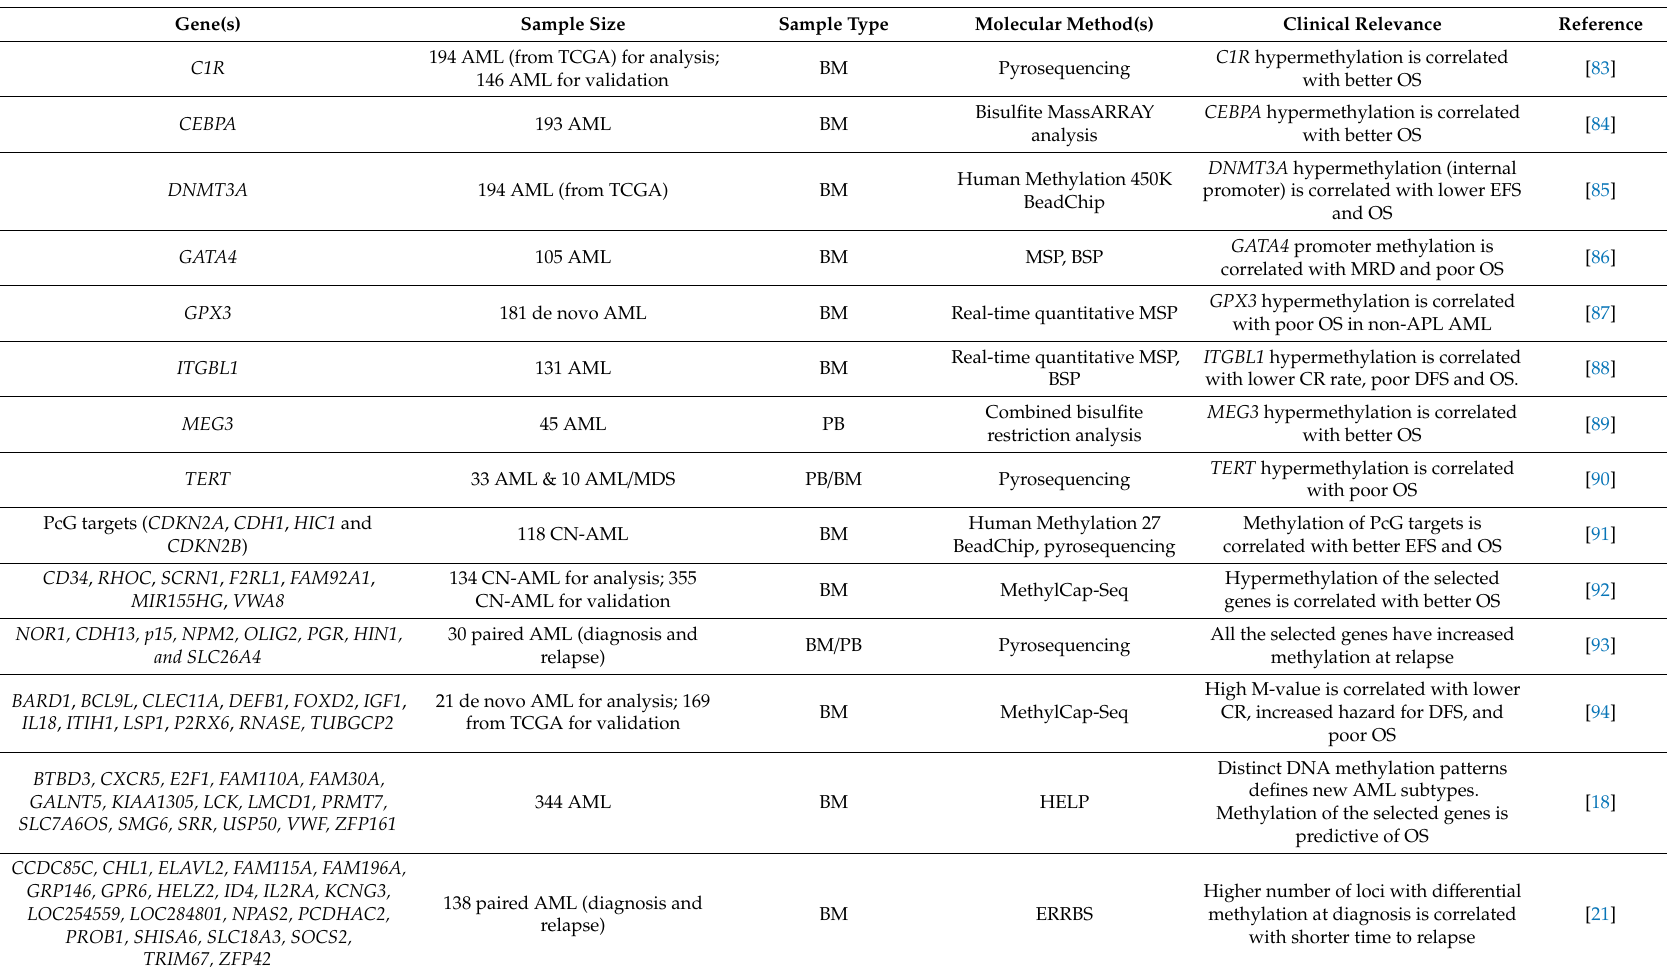
Table 1. Clinical implications of DNA methylation in acute myeloid leukemia